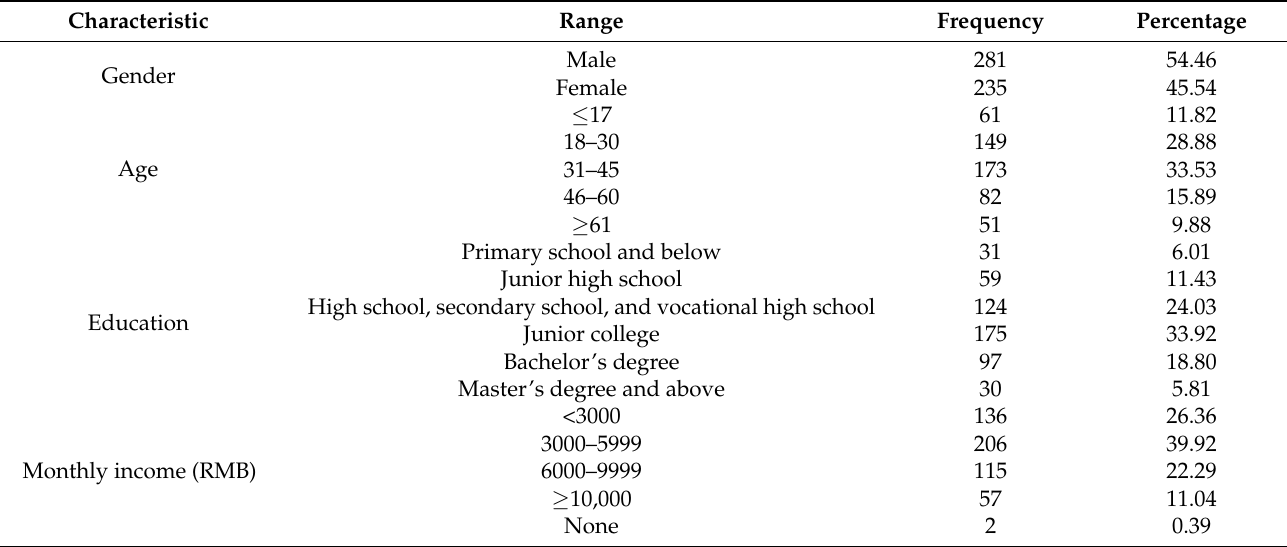
Table 2. The sample